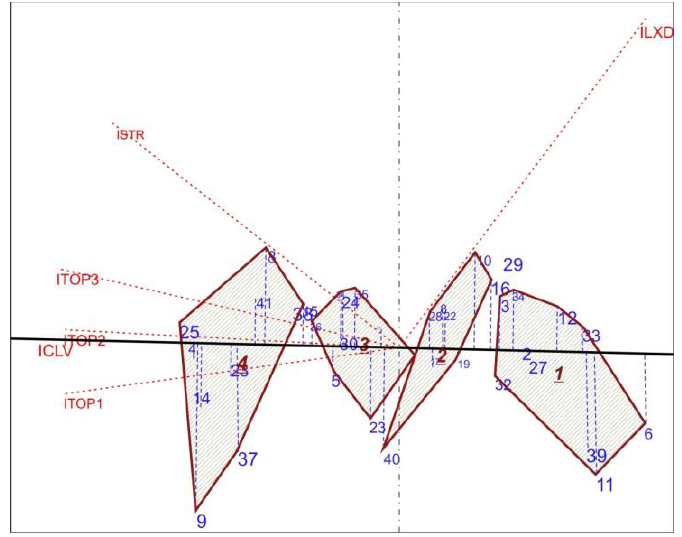
Figure 10. HJ-biplot and clustering of texts belonging to data set 3, with 41 texts in blue numbers and red strings as latent variables..